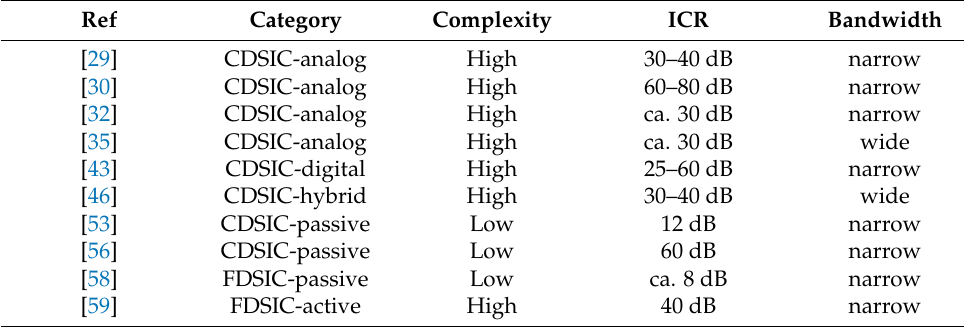
Table 1. Key performance comparison of typical circuit and field-domain SIC.